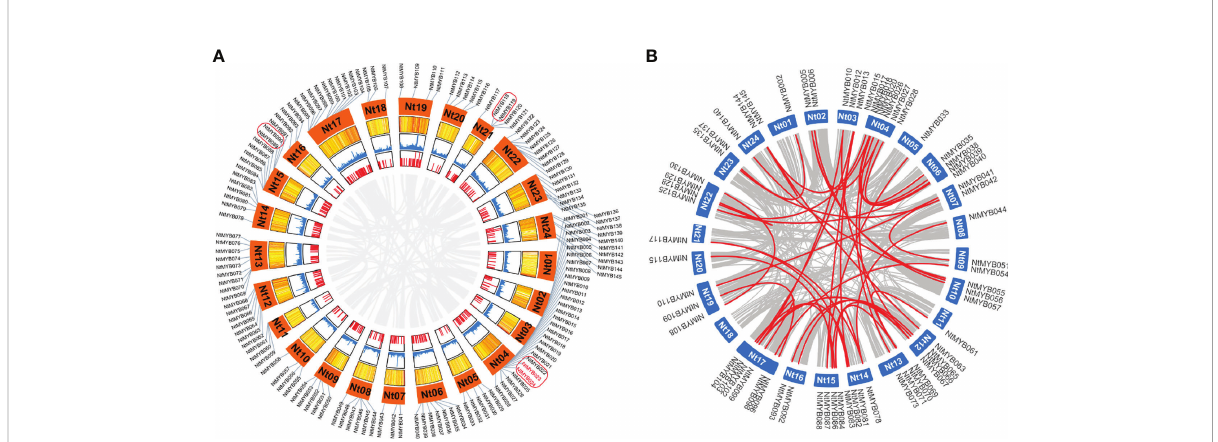
FIGURE 3 The chromosomal distribution and duplication events. (A) The distribution of tobacco R2R3-MYB genes on chromosomes. A total of 145 R2R3- MYB genes anchored on tobacco chromosomes. The red box suggests the gene cluster, while the tandem duplication gene pair is colored red. (B) The tobacco R2R3-MYB genes segmental duplication events and inter-chromosomal relationships. The 42 segmental duplication pairs of NtMYB genes are predicted by MCScanX and linked by the red lines, respectively. In addition, the gray lines stand for all putative sefmental duplication pairs in the tobacco genome